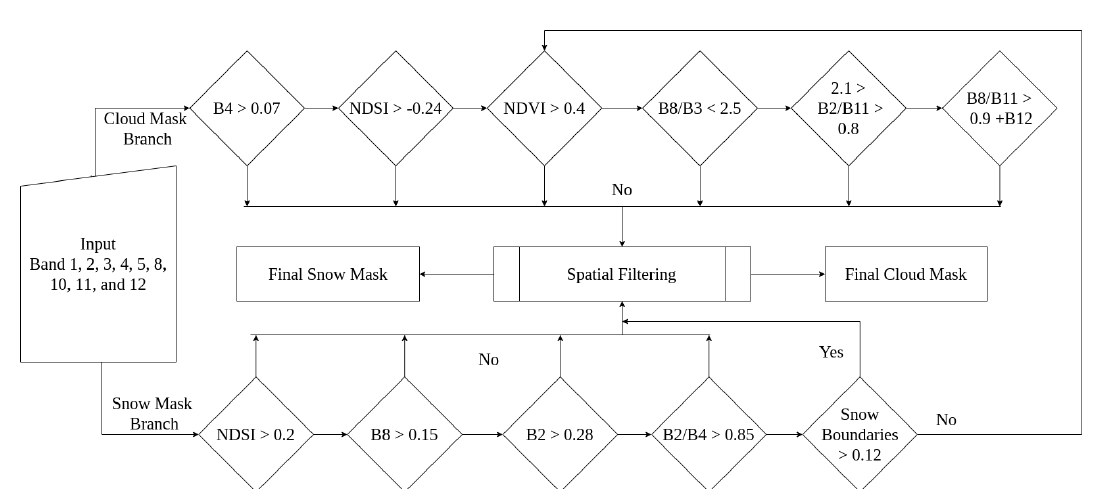
Figure 1. Sen2cor Cloud and Snow Mask